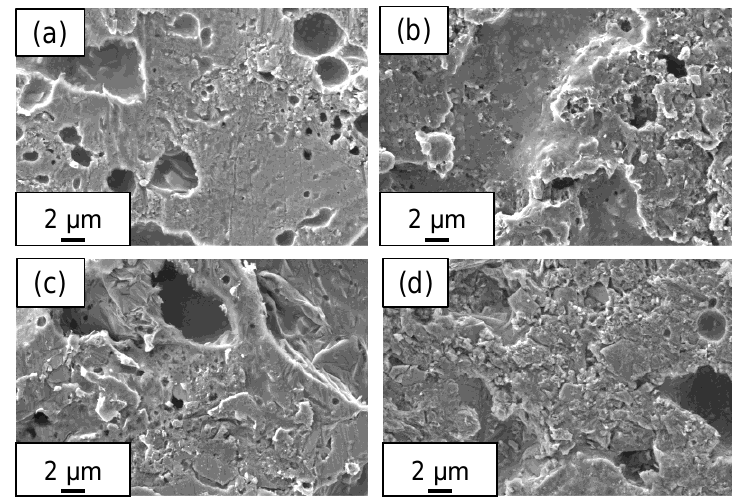
Figure 11. Fracture surfaces of RMF-brazed joints, with an RMF thickness of ( a ) 66 μm, ( b ) 99 μm, ( c ) 132 μm, and ( d ) 165 μm.